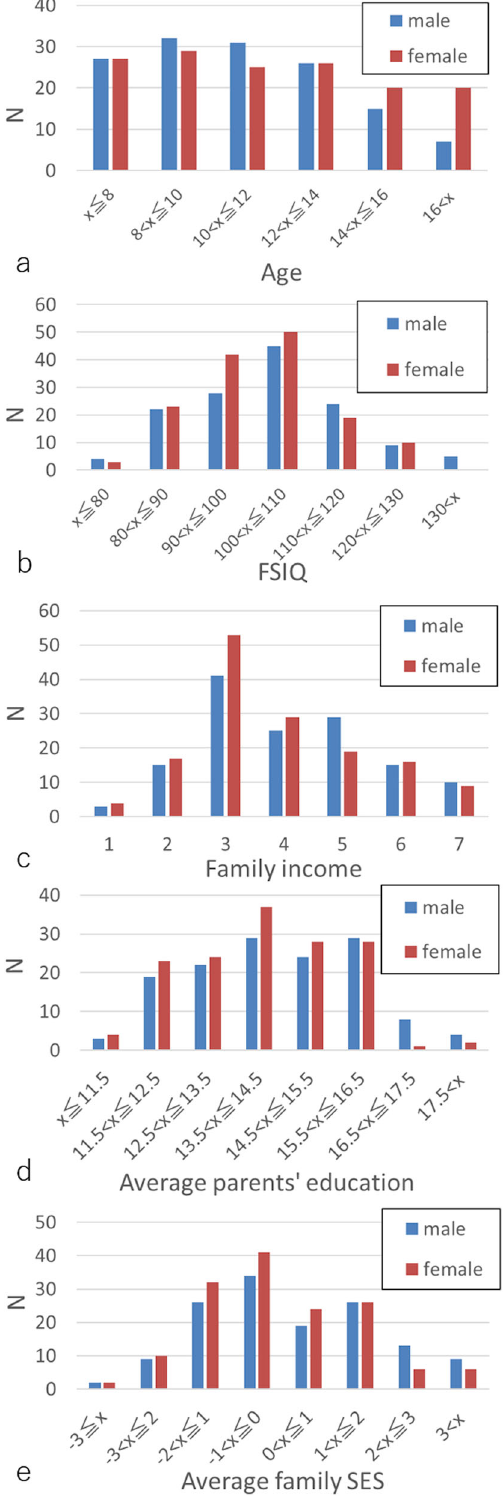
Fig. 1 Distributions of the key variables of the study. Histograms showing ( a ) age, (b) FSIQ, ( c ) family income, ( d ) average parents ’ education length, and ( e ) the composite childhood SES score of boys and girls in the